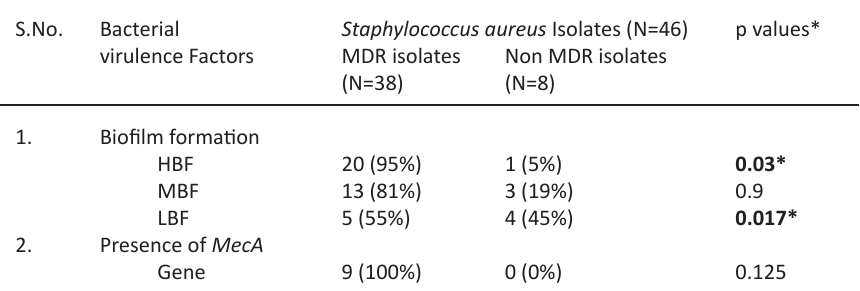
Table 2. Association of bacterial virulence factors (biofilm formation and presence of mecA gene) with antibiotic sensitivity